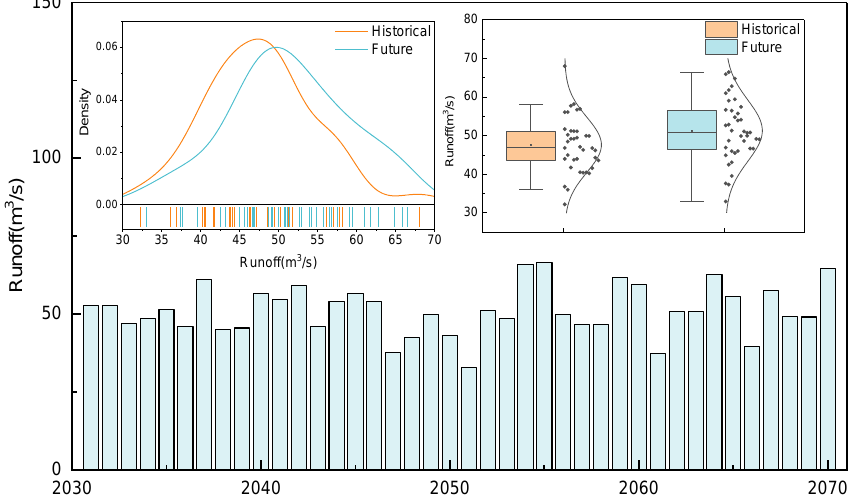
Figure 9. Comparison of the projected runoff from 2031 to 2070 and the historical runoff from 1961 to 2000.